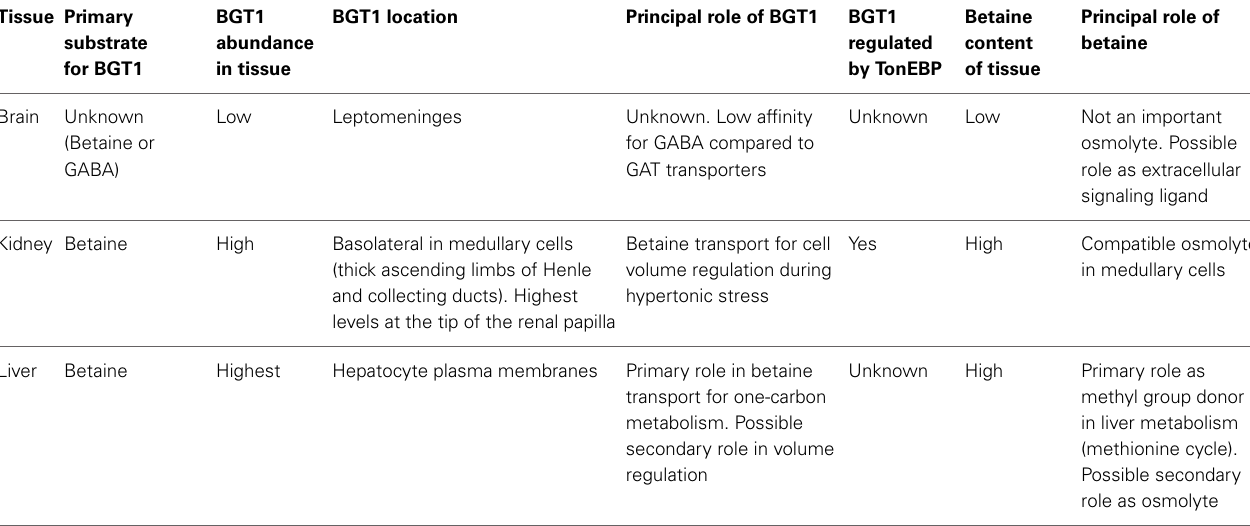
Table 3 | Summary of functions of BGT1 and betaine in mouse tissues. Tissue